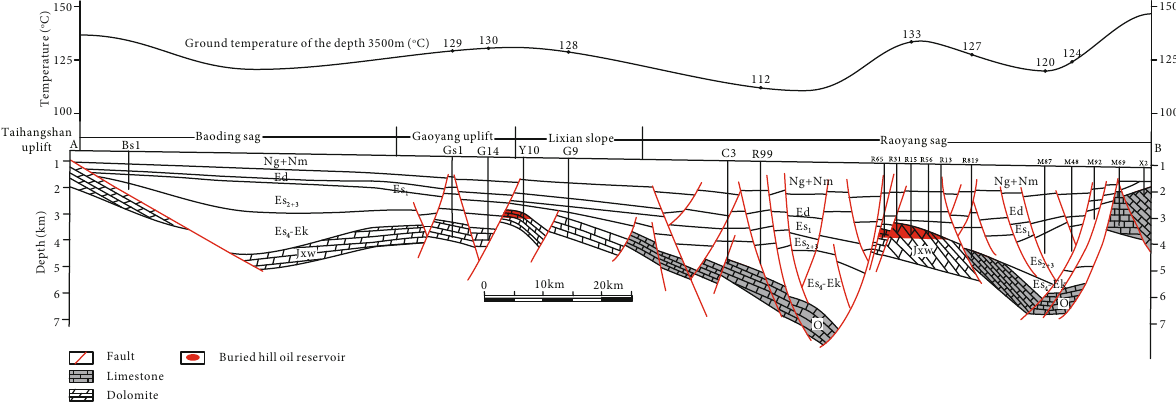
Figure 4: Formation (depth 3500 m) temperature and stratigraphic distribution in the study